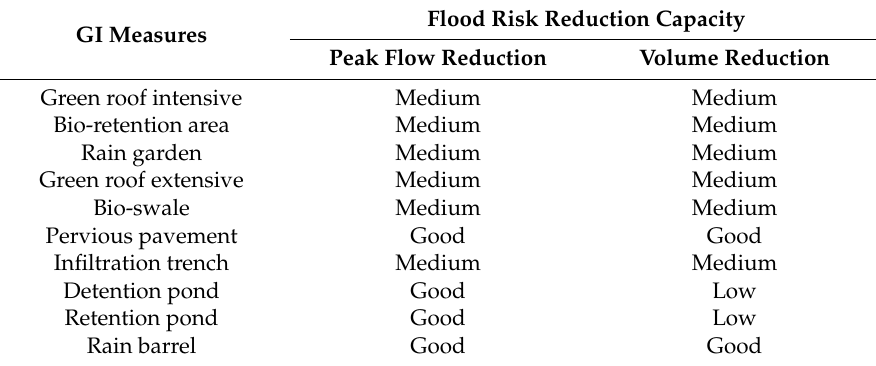
Table 6. Flood risk reduction capacity of selected GI measures